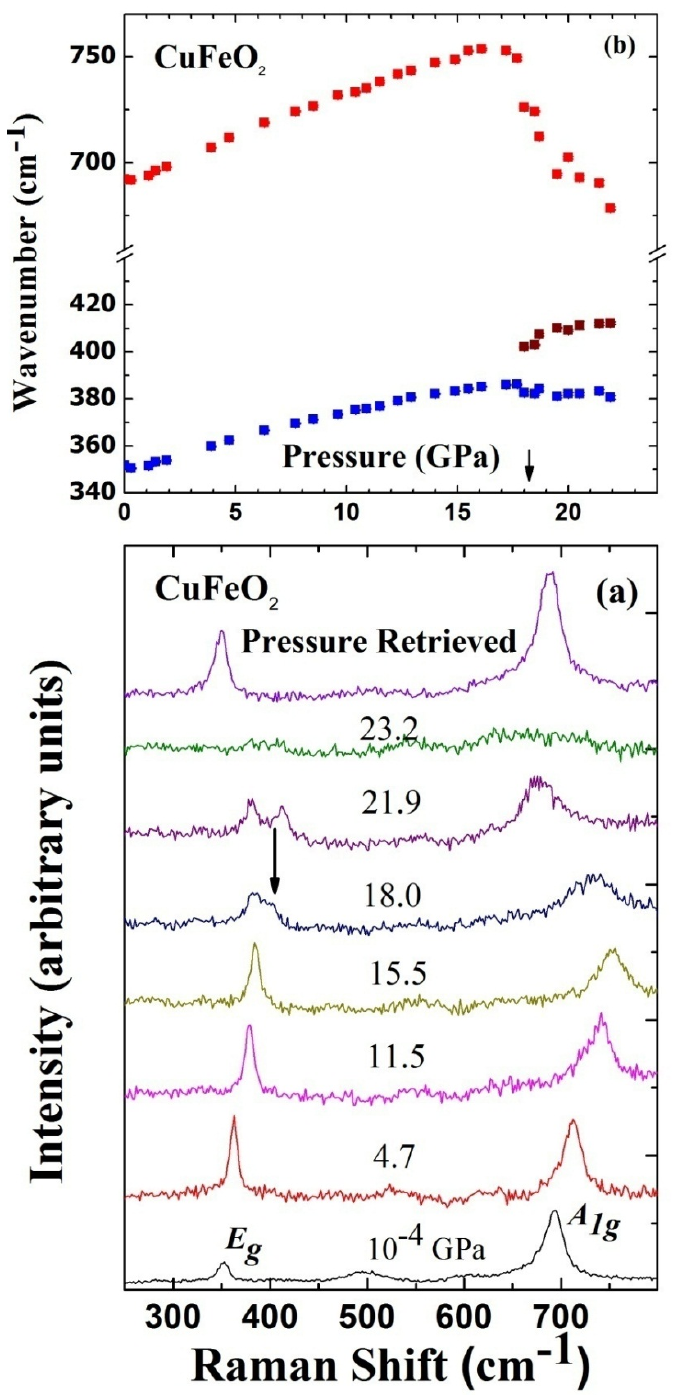
Figure 12. Evolution of Raman modes with pressure for CuFeO 2 ( a ), Mode frequency vs. Pressure ( b ). Arrow in ( a ) shows splitting of E g mode indicating the transition. Figures after Reference [76].